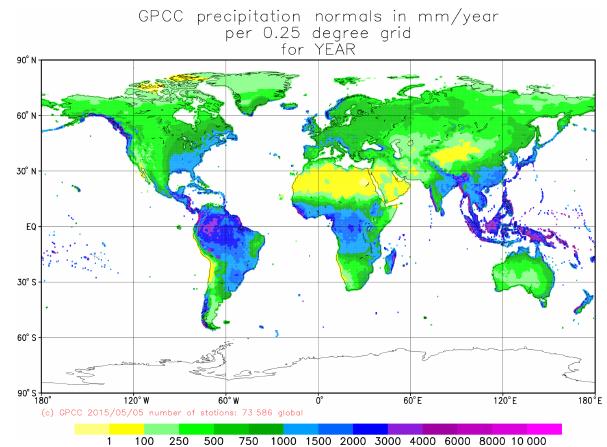
Figure 2. GPCC Climatology V2015, annual totals in mm are shown at 0.25 ◦ resolution.